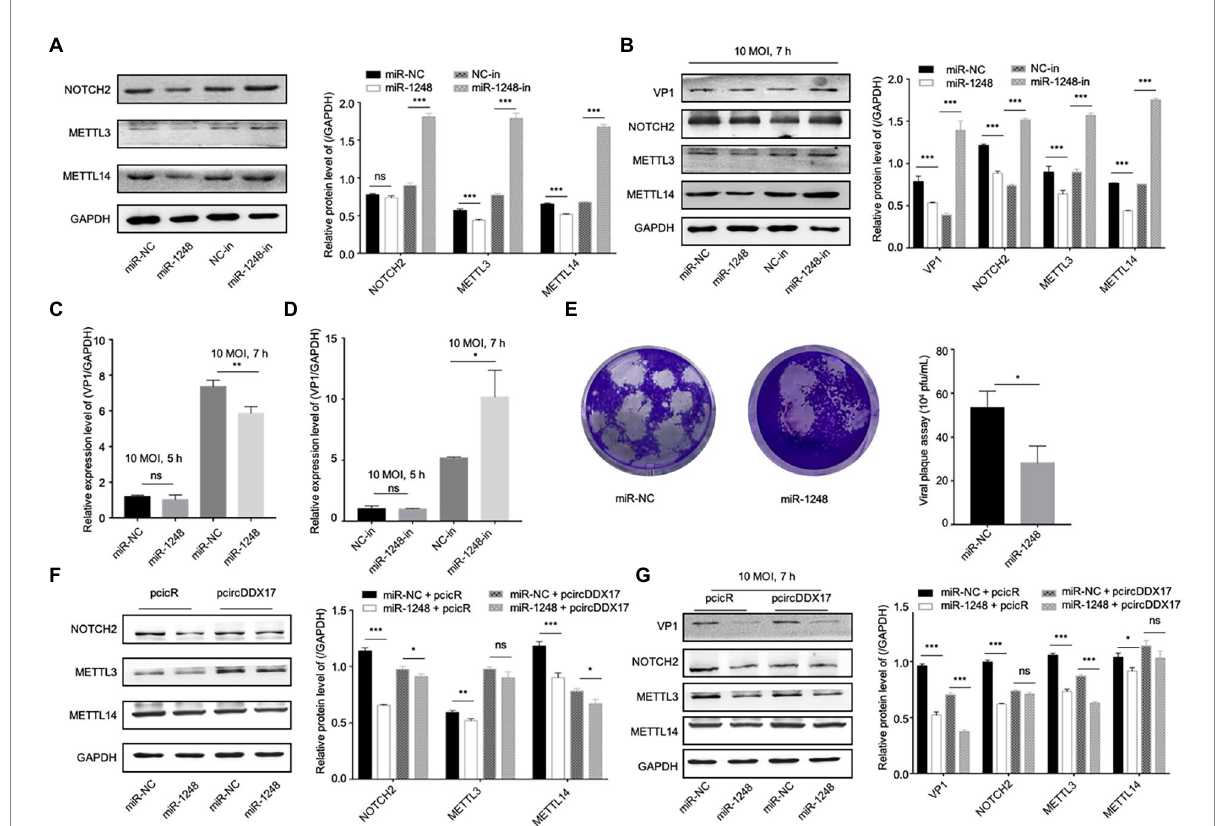
FIGURE 5 CircDDX17 regulates NOTCH2 expression by targeting miR-1248, influence the methylation-related pathway after CVB3 infection. (A) HeLa cells transfected miR-1248 mimics or miR-1248-inhibitor, indicated signals were detected by Western blot. (B) HeLa cells transfected miR-1248 mimics or miR-1248-inhibitor, and infected CVB3 (10 MOI) for 7 h indicated signals were detected by Western blot. (C) HeLa cells transfected the miR-1248, infected CVB3 (10 MOI) for 7 h, RT-qPCR to detect the VP1 expression. (D) HeLa cells silenced miR-1248 and infected CVB3 (10 MOI) for 7 h, RT-qPCR to detect the VP1 expression. (E) Viral titers were determined by plaque assay using the supernatants of HeLa cells overexpression miR-1,248 ( n = 3). (F) HeLa cells co-transfected miR-1248 and pcircDDX17, indicating signals were detected by Western blot. (G) HeLa cells co-transfected miR-1248 and pcircDDX17, cells infected CVB3 (10 MOI) for 7 h, indicated signals were detected by Western blot. * p < 0.05, ** p < 0.01, *** p <